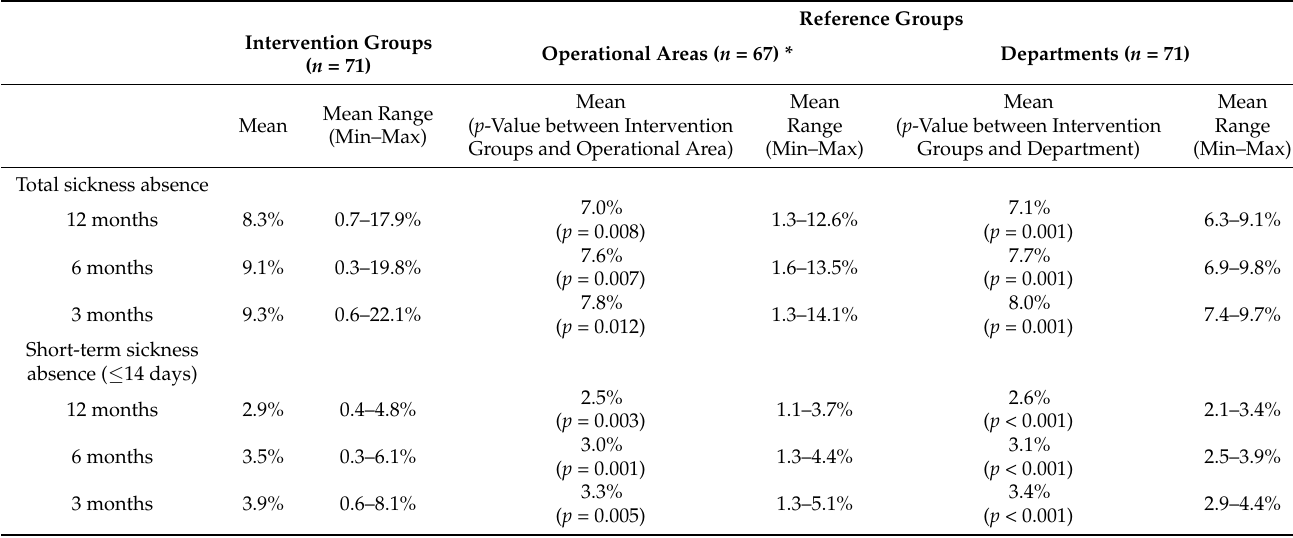
Table 3. Average levels and range of total and short-term sickness absence registered 12, 6, and 3 months prior to implementation of the measures (2017 and 2018), in the intervention and reference groups, and p -values for the respective differences between these